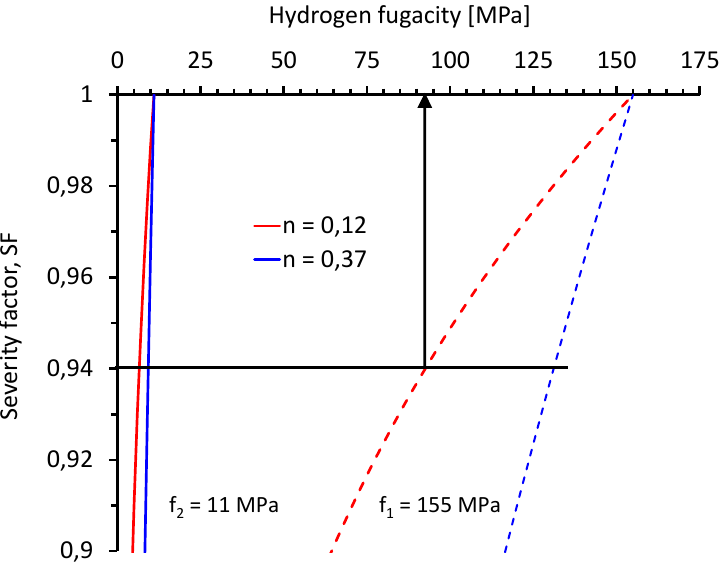
( b ) Figure 6. ( a ) Histogram of the fit exponents ( |(cid:1866)| ) from Table 1, ( b ) corresponding Weibull curves, scale parameter 1.727, shape parameter 0.195, coefficient of determination R 2 = 0.895. The following discussion focuses on the two characteristic |(cid:1866)| values, i.e., |(cid:1866)| = 0.12 and |(cid:1866)| = 0.37. To discuss the effect of these results on the definition of hydrogen test fugacities (pressures), two engineering applications were selected as use cases. The typical test pressure for automotive hydrogen tanks is 87.5 MPa ( f 1 = 155 MPa) and the typical operating pressure of gas pipelines is 10 MPa ( f 2 = 11 MPa). These nominal fugacities were used to calculate severity factors as (cid:1845)(cid:1832) (cid:2869),(cid:2870) = (cid:4678) (cid:1858) (cid:1858) (cid:2869),(cid:2870) (cid:4679) (cid:3041) , (cid:1858) < (cid:1858) (cid:2869),(cid:2870)